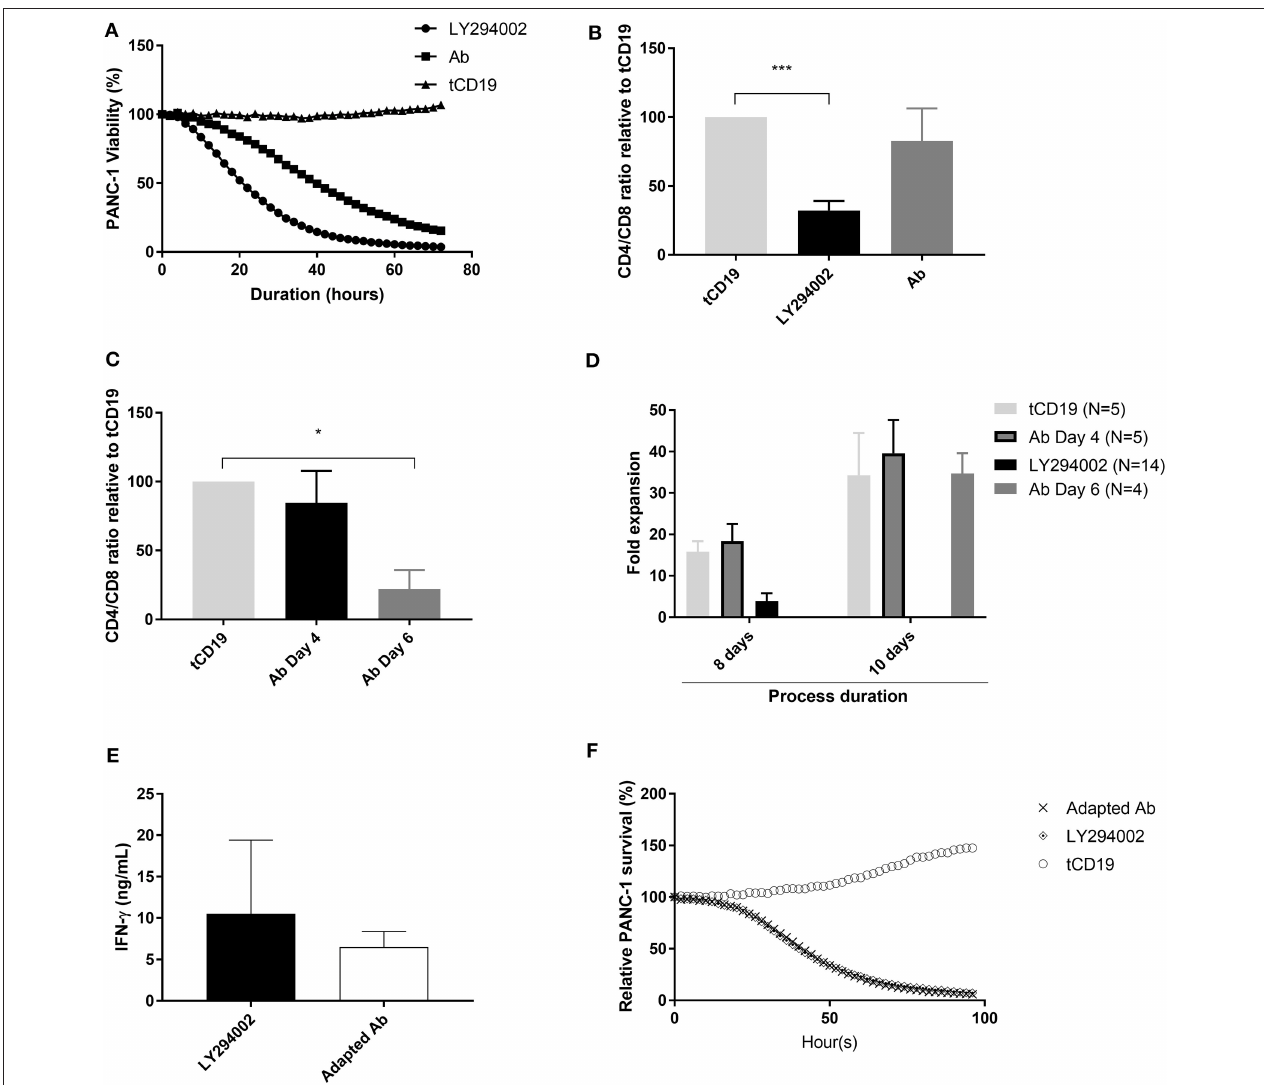
FIGURE 4 | NKR-2T cells Ab blockade process adaptation restores CD4/CD8 ratio . (A) Cytolytic activity kinetics, one representative killing assay out of three. Thawed control tCD19T cells or NKR-2T cells treated with PI3K inhibitor LY294002 or with the blocking Ab were cultured in presence of NucLight positive PANC-1. PANC-1 viability was assessed every 2h by the IncuCyte S3 device. (B) CD4/CD8 distribution at harvest. During expansion phase, NKR-2T cells were either cultured with 5 µ M of LY294002 or with 5 µ g/mL of blocking Ab for 96h, harvested and measured by Flow cytometry for the CD4 and CD8 population. Data shown are mean ± SD of N = 4 independent T cell donors relative to the control tCD19 ratio. (C) CD4/CD8 distribution at harvest with a delayed addition of blocking Ab. During expansion phase (day 4 to day 8), NKR-2T cells were either directly treated with 5 µ M of blocking Ab (day 4) or after 48h (day 6). At harvest (day8), T cells were harvested and analyzed by Flow cytometry for the CD4 and CD8 populations. Data shown are mean ± SD of N = 3 independent T cell donors relative to control tCD19 CD4/CD8 ratio. (D) Comparison of expansion. NKR-2T cells were either cultured for 8 or 10 days in presence of LY or blocking Ab (added at day 4 or at